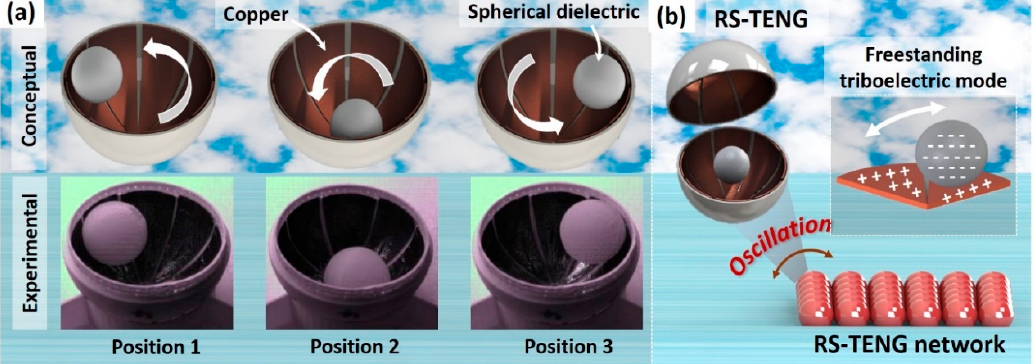
Figure 1. Structural principle of the RS-TENG: ( a ) RS-TENG oscillation scenarios in a spherical frame along with a comparison to experimental observations captured by a high-speed camera; ( b ) the application of the RS-TENG in ocean waves and principle of the copper (Cu) RS-TENG, including the copper (Cu) structure and spherical dielectric.